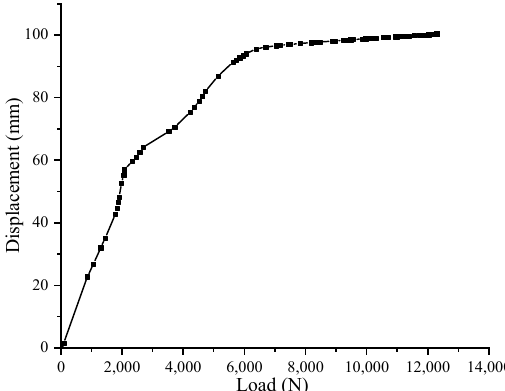
Figure 3. Load characteristic curve under the zero-pressure condition.